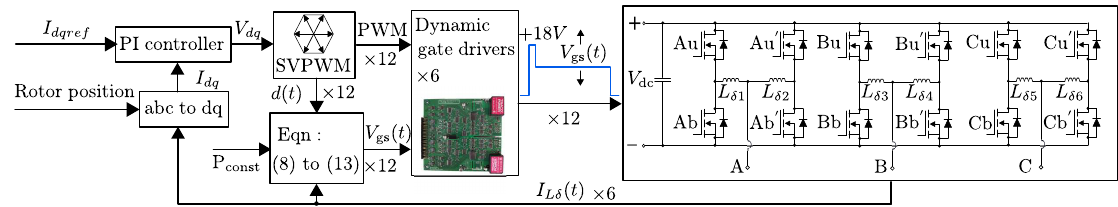
Figure 7. System operation principle of a motor driver consisting of six half-bridge